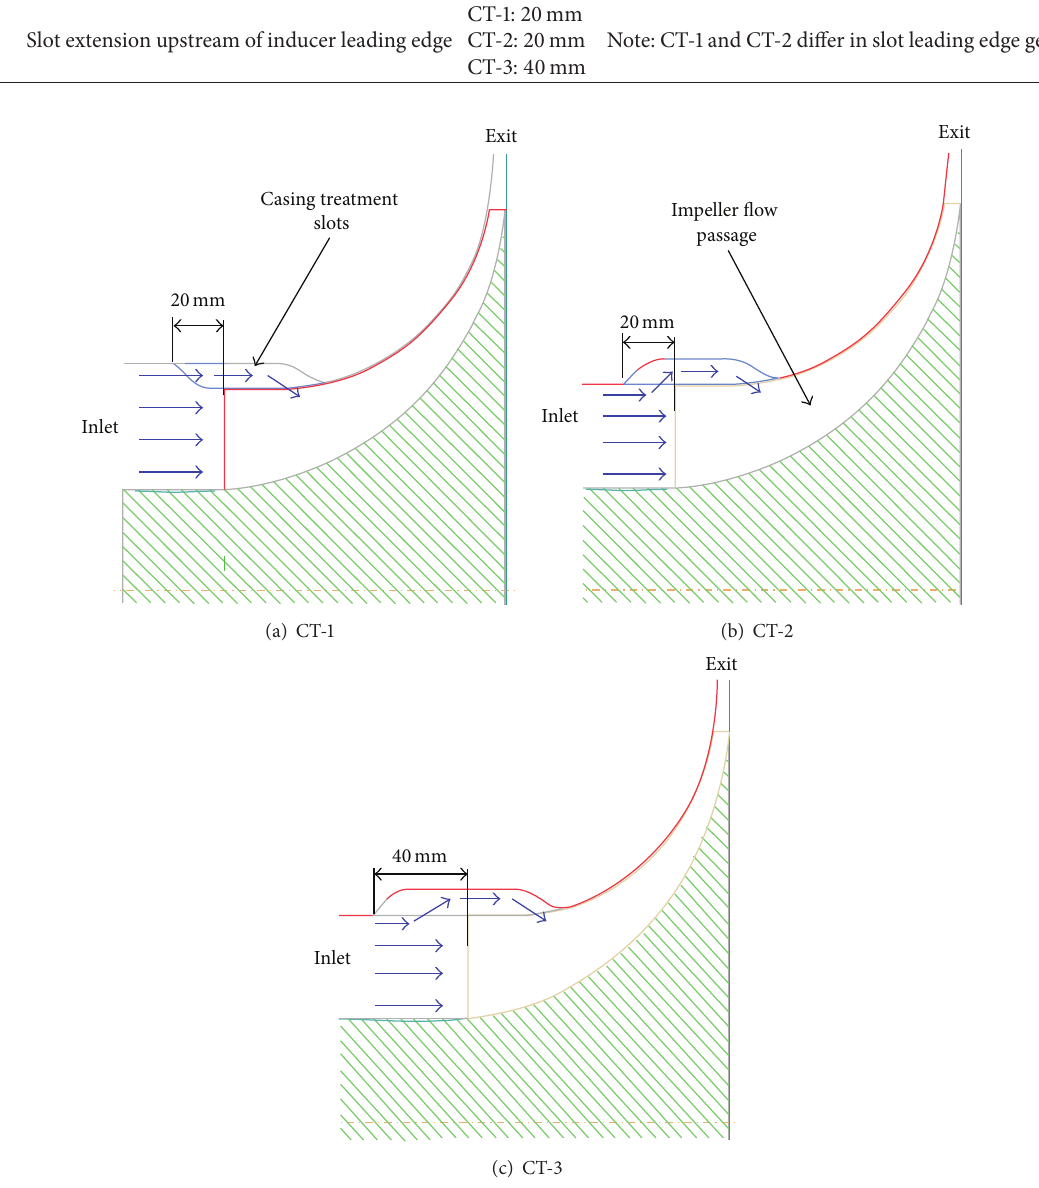
Figure 2: Casing treatment configurations in meridional